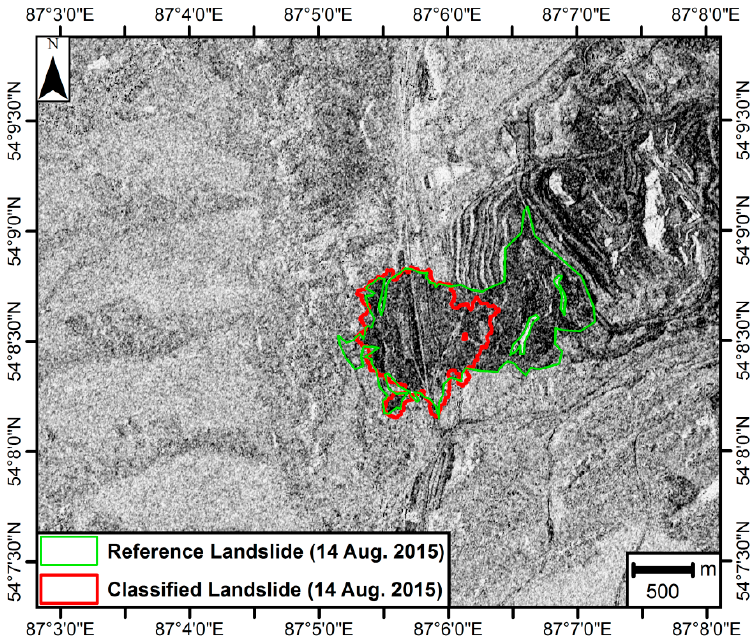
Figure 9. Result (red) of the landslide detection procedure at the Russian mining waste site based on post-event dual-pol TerraSAR-X (acquired on 14 August 2015; background image) and pre-event optical Landsat-8 (14 September 2014) imagery. Green: reference derived by visual interpretation and manual digitization of the TerraSAR-X imagery. TerraSAR-X © 2015 German Aerospace Center (DLR), 2015 Airbus Defence and Space/Infoterra GmbH.